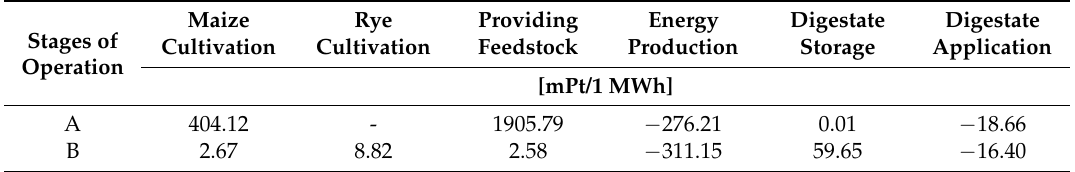
Figure 2. Environmental effects of the biogas plan operation expressed as impact categories. Table 3. Negative and positive environmental impact of the analysed biogas plants expressed as a result of cumulative eco-indicator, broken down into stages of a biogas plant operation.